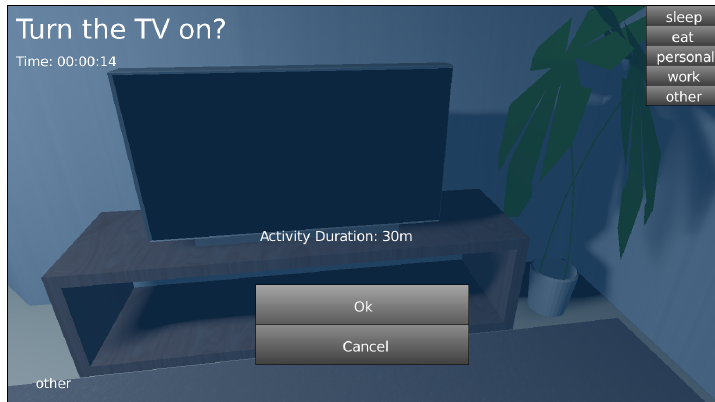
Figure 4. The activity selection and fast-forwarding dialogue.